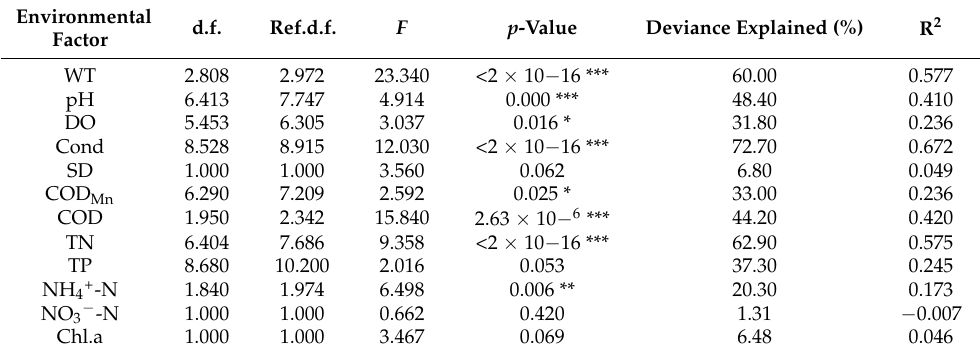
Table 4. GAM model analysis of TOC concentration and environmental factors in the Dan